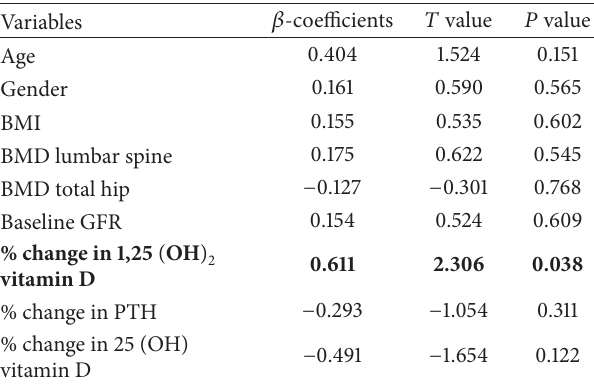
Table 3: Multilinear regression analysis of the % change in the Wnt inhibitors, sclerostin and DKK1 as dependent variable and % vitamin D as independent variable, following change in 1,25 (OH) 2 correction for age, gender, and BMD. Highlighted bold is the significant variables. Dependent variable: combined % change in DKK1 and